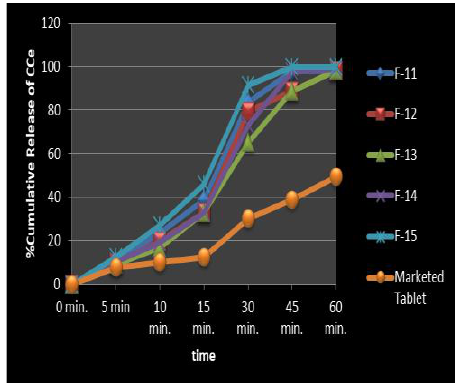
Figure 7. Comparative dissolution profile for formulas (F-11 to F-15) and marketed tablet of CC. in 0.1N HCl (pH 1.2) with 0.5 % tween 20 at 37 °C. In vitro drug release kinetics study The result of release kinetic of all CC SEDDS formulations illustrated in table 8. The best fit (highest R2 value) was found to be Korsmeyer-peppas equation and n value of above 0.5 and below 0.89 which indicated that the release mechanism was anomalous and the release was ruled by both diffusion of the drug and dissolution/ erosion.